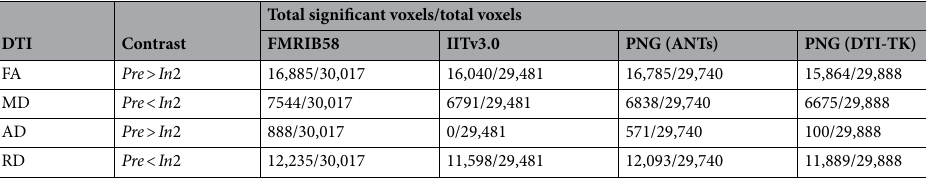
Table 2. Summary of the ratios of the number of statistically significant voxels of DTI metrics (FA, MD, AD, RD) and the total number of voxels on TBSS skeleton. For details with respect to each ROI, see Supplementary Tables S1-S4 online.